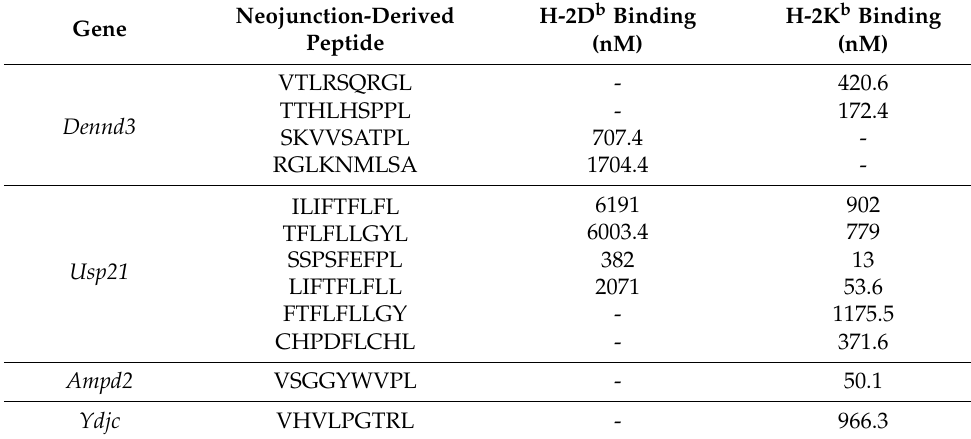
Table 2. Intron retention-derived peptides and predicted MHC class I binding affinities selected for CD8 + T cell immunogenicity